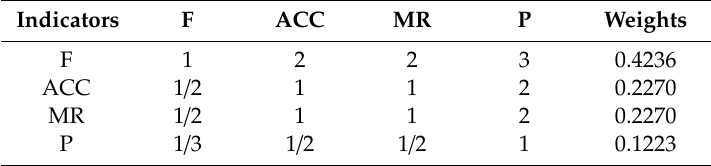
Table 3. Judgment matrix of the performance evaluation indicators.